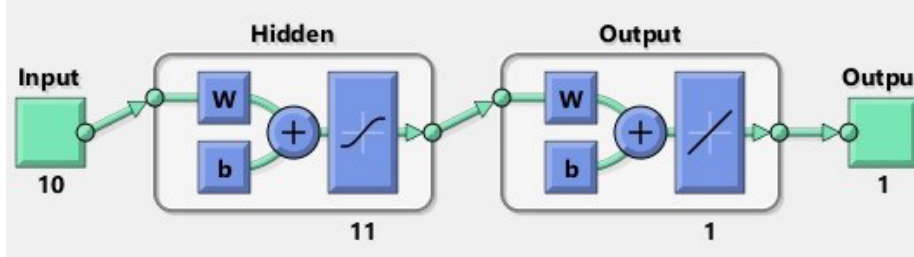
Figure 4. Resulting artificial neural network architecture.